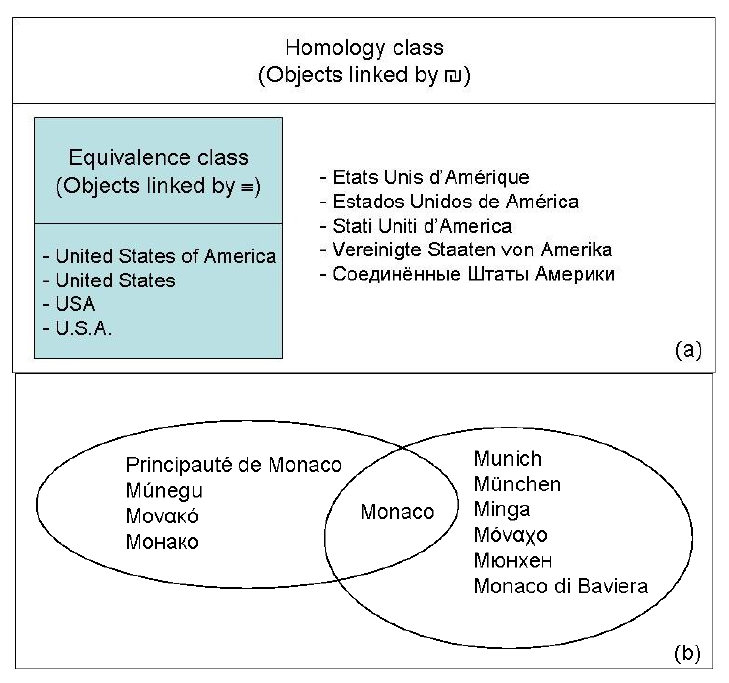
Figure 10. ( a ) Emphasizing the differences between equivalence and homology for toponyms; ( b ) example of a toponym (Monaco) belonging to two homology